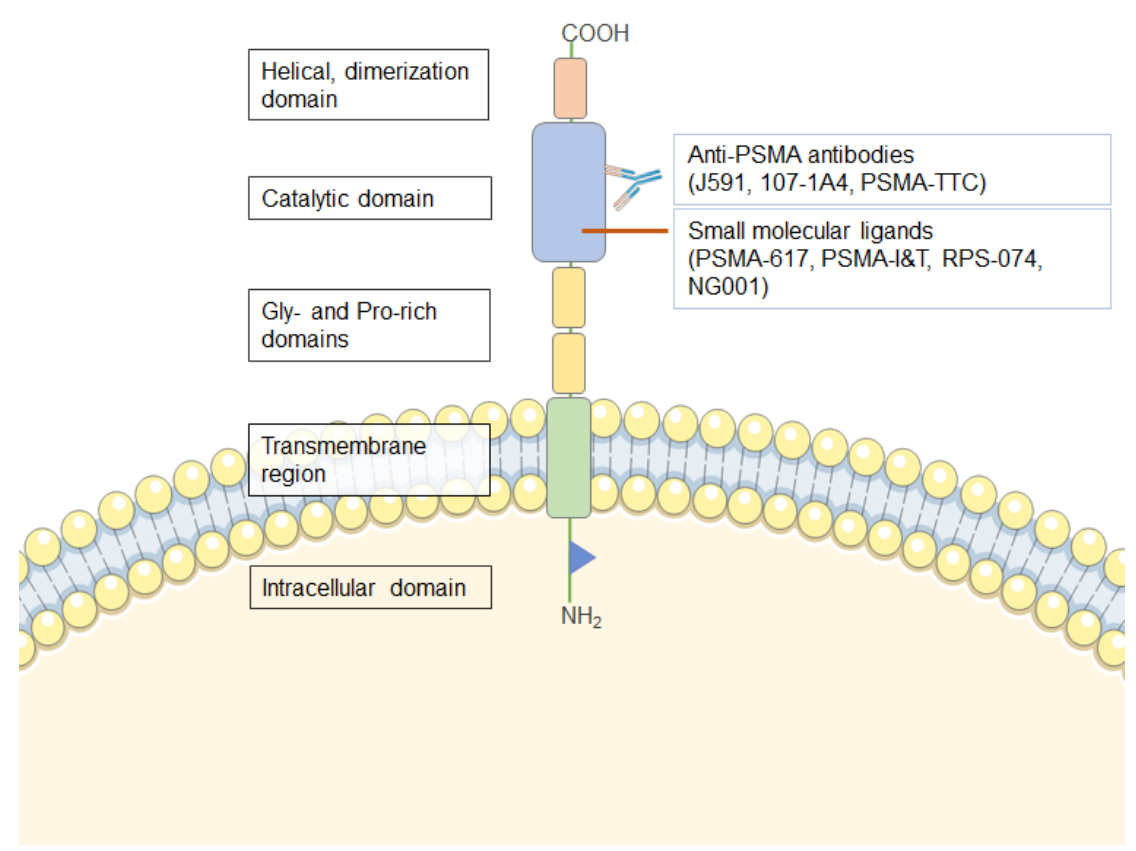
Figure 1. The simplified structure of prostate-specific membrane antigen (PSMA), its binding sites for PSMA ligands and antibodies (this figure is based on references [52–54]).